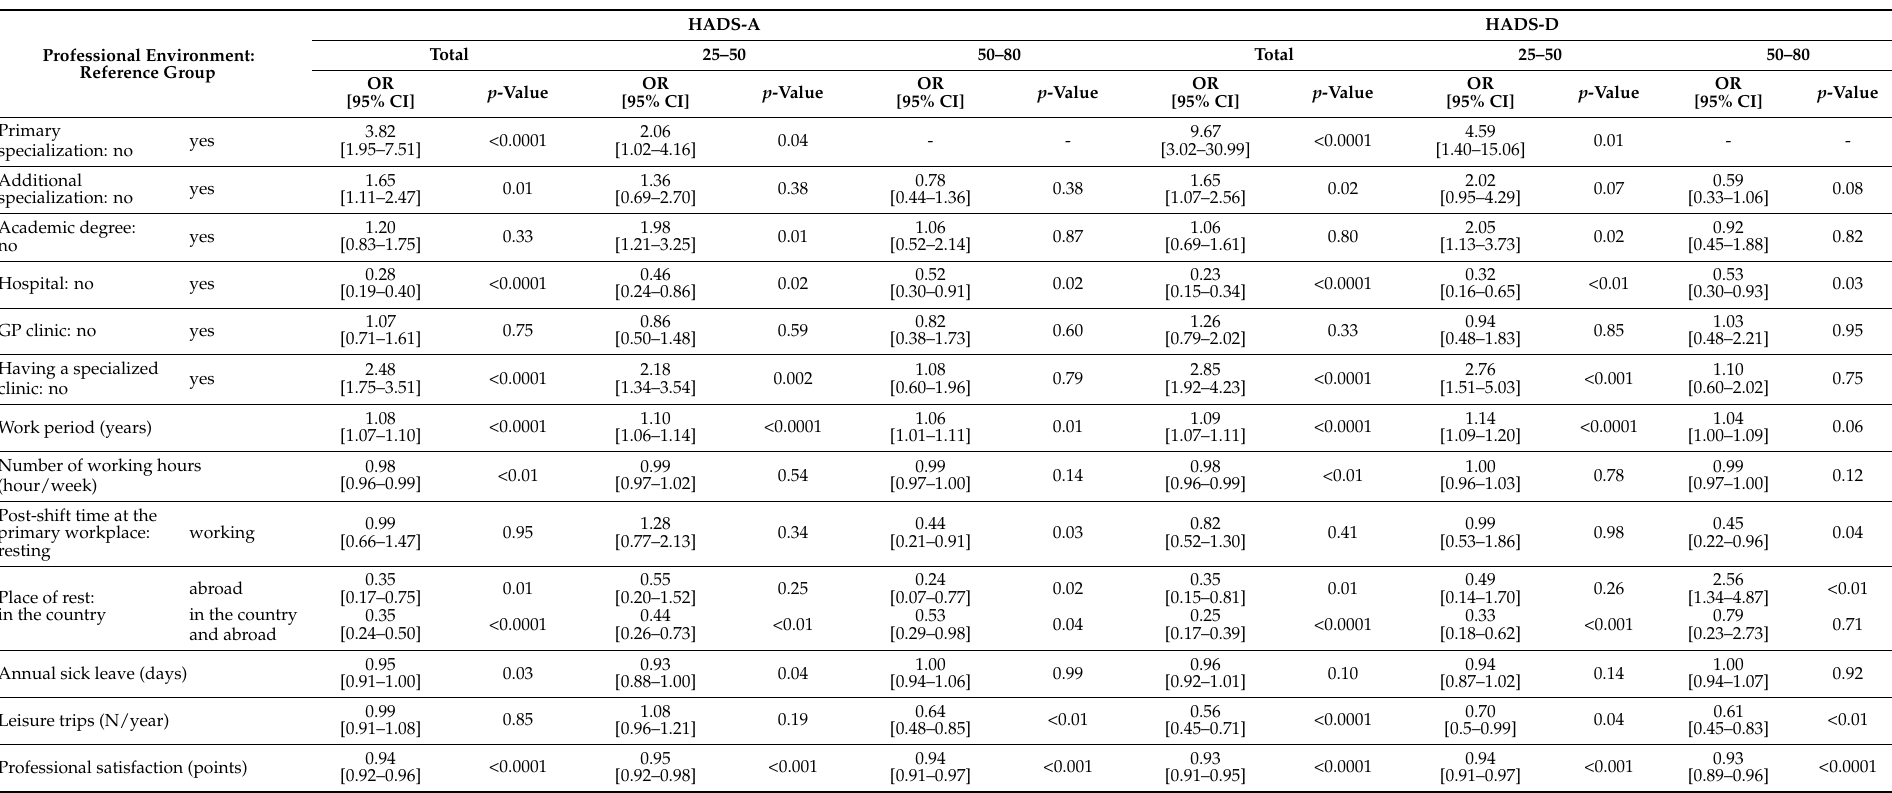
Table 3. Crude odds ratios (OR) with 95% confidence interval (CI) for the relationship between the occurrence of anxiety disorders (12 points or more on the HADS-A scale) and depression (12 points or more on the HADS-D scale) and occupational